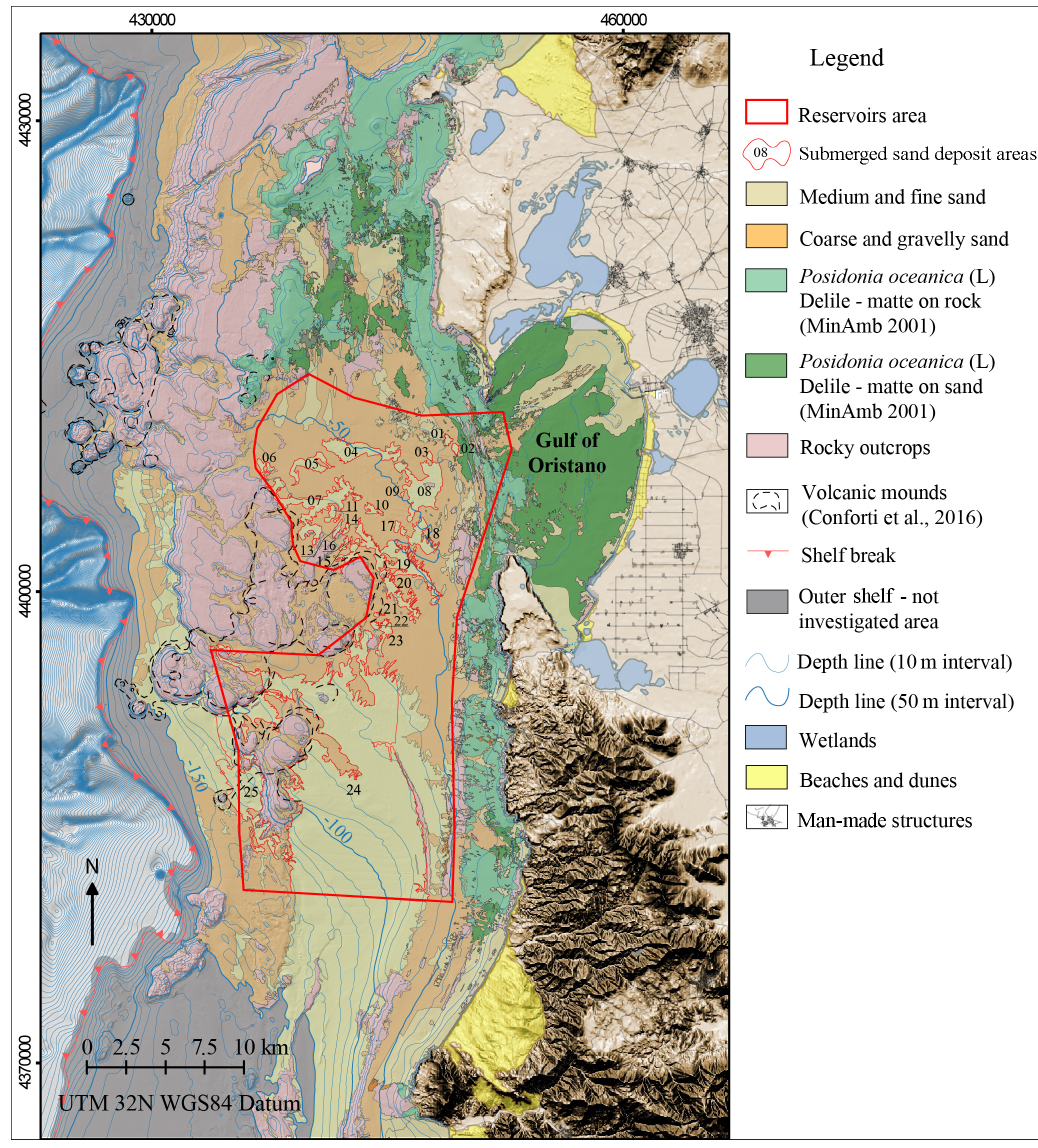
Figure 6. Map of seabed features of the continental shelf of central–western Sardinia.